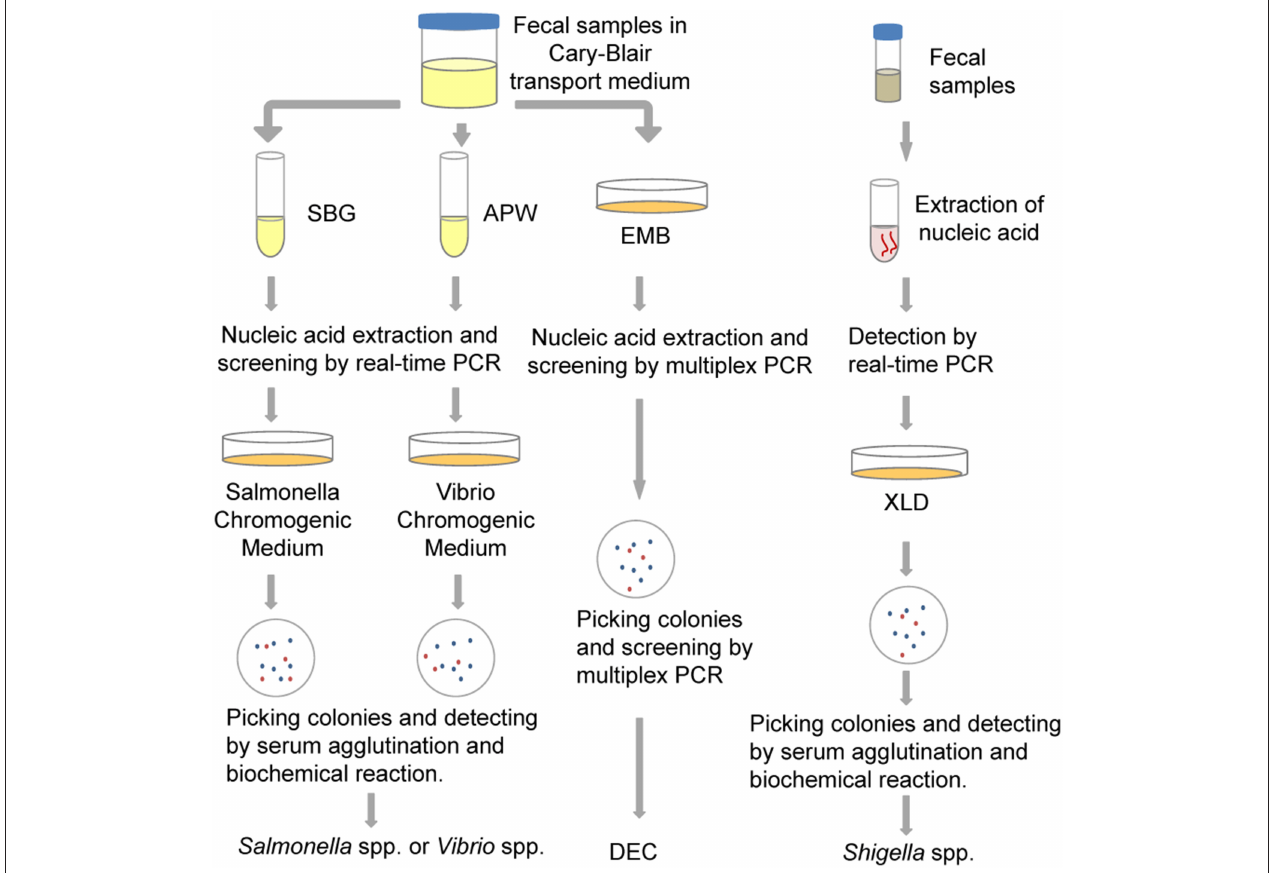
FIGURE 3 | The protocol for multiple pathogen surveillance (developed as a result of this study). APW, Alkaline Peptone Water; DEC, diarrheagenic Escherichia coli ; EMB, Eosin Methylene Blue agar; SBG, Selenite Brilliant Green Broth; XLD, Xylose Lysine Deoxycholate